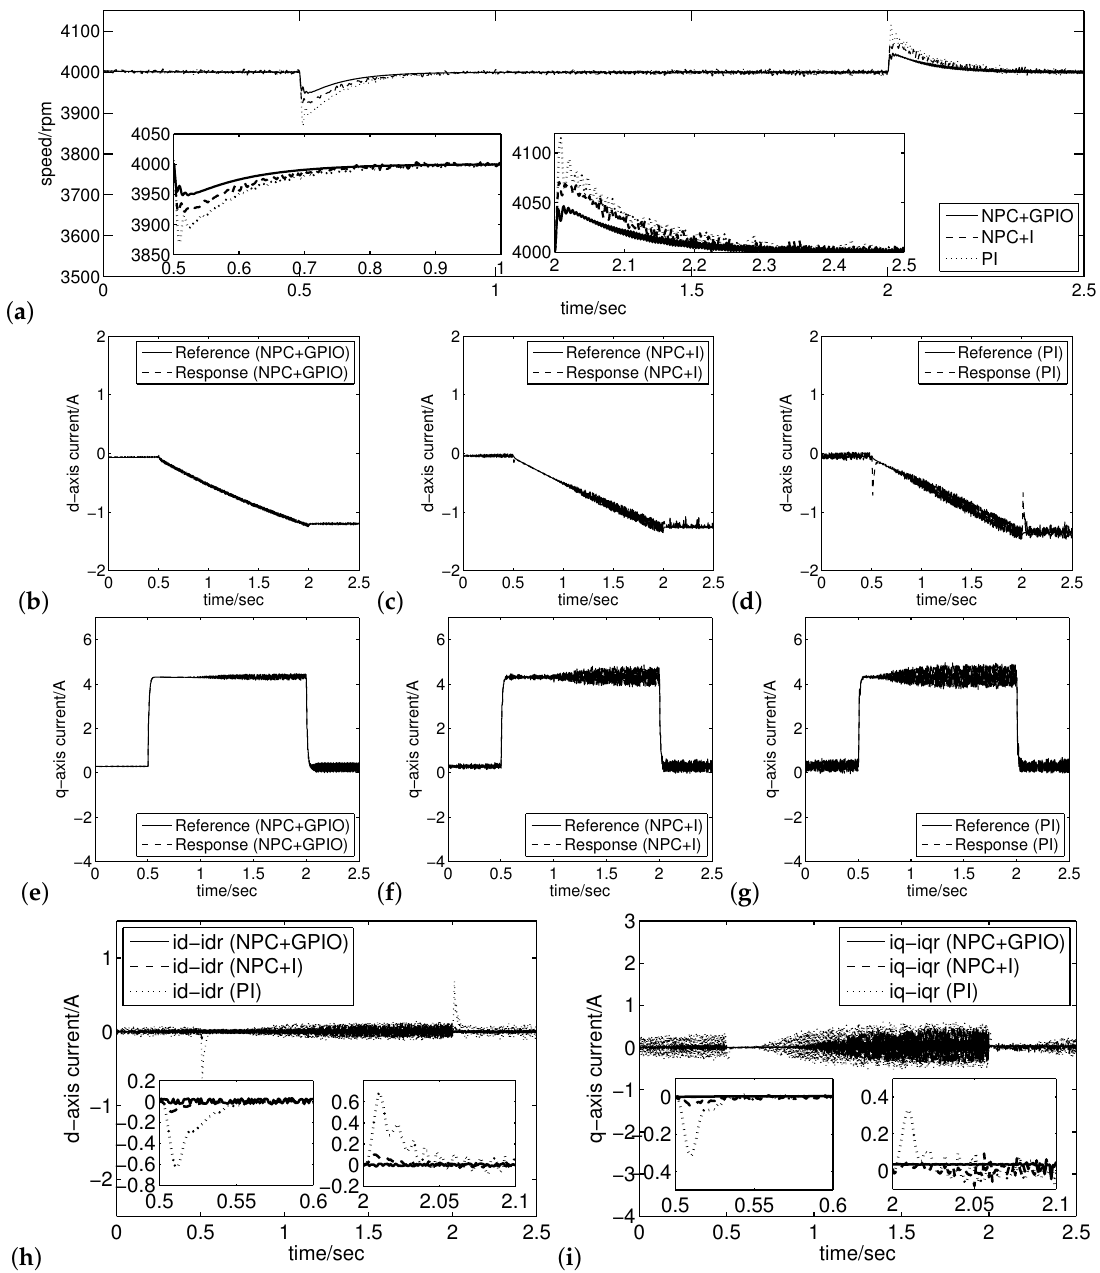
Figure 12. Speed and current responses with operation speed at 4000 rpm in the case of 1.5 N · m load torque (nominal power) under the same speed controller (PI) and the different current controllers (the proposed controller (NPC + GPIO), the integral controller (NPC + I) and the improved PI controller): ( a ) speed responses; ( b ) d-axis current response under the proposed controller; ( c ) d-axis current response under the integral controller; ( d ) d-axis current response under the PI controller; ( e ) q-axis current response under the proposed controller; ( f ) q-axis current response under the integral controller; ( g ) q-axis current response under the PI controller; ( h ) d-axis current-tracking errors under the different current controllers (the d-axis response current (id) minus the d-axis reference current (idr)); ( i ) q-axis current-tracking errors under the different current controllers (the q-axis response current (iq) minus the q-axis reference current